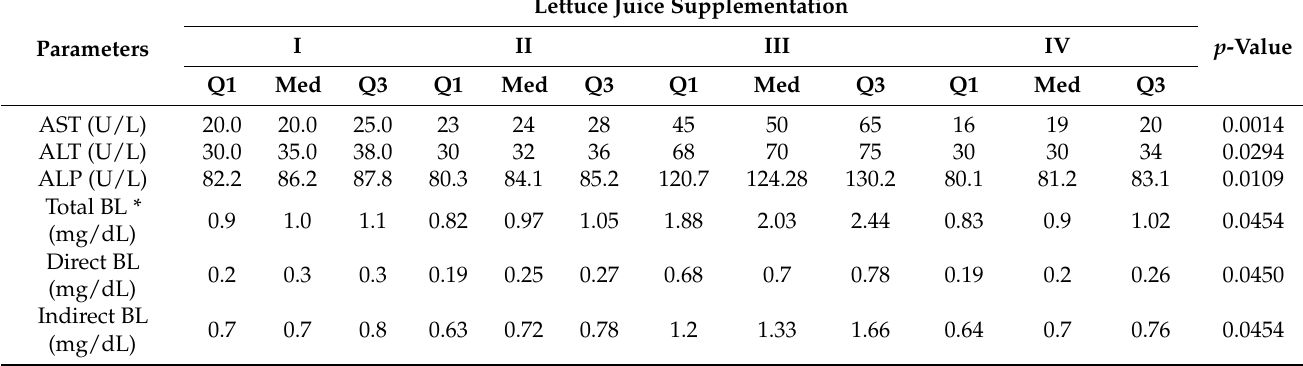
Table 7. Med, first, and third quartile (Q1 and Q3) of liver biomarkers in sera of rabbits administered nitrate- or WPH- fertilized lettuce juice (10 mL/animal daily) as compared to that of nonfertilized lettuce or lettuce-free diet (groups II and I, respectively).